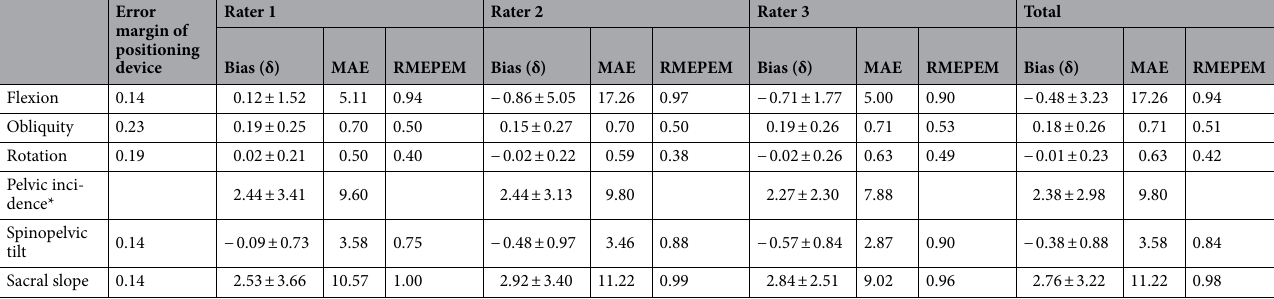
Table 1. Trueness of EOS measurements in terms of pelvic parameters and orientation. RMEPEM rates of measurement errors out of positioning error margin, MAE maximum of absolute error. *Morphologic